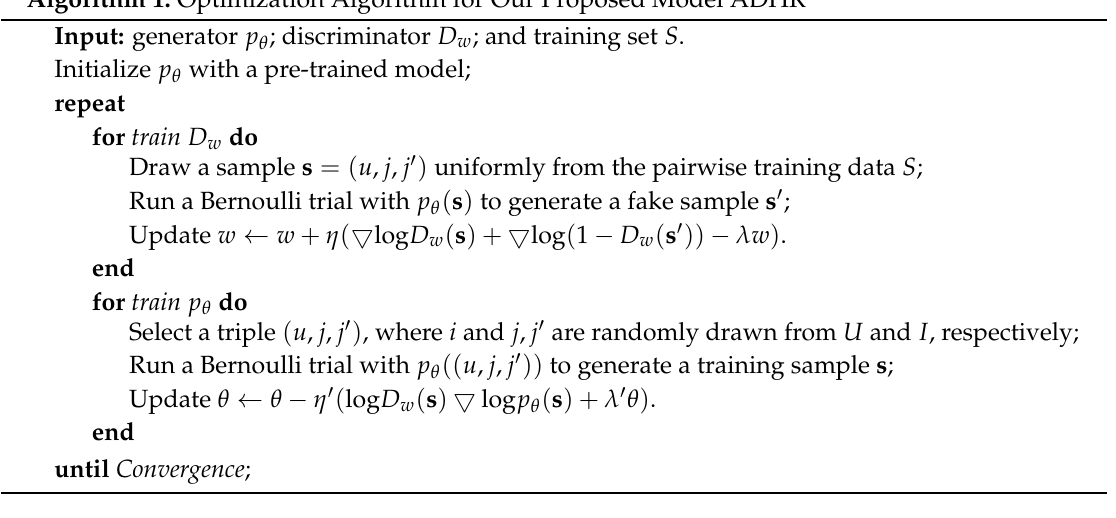
Algorithm 1: Optimization Algorithm for Our Proposed Model